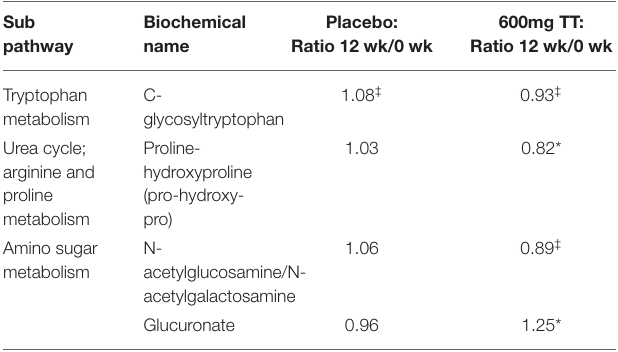
TABLE 2 | Changes in metabolites associated with redox environment in serum of the Placebo and the 600mg TT groups at 0 and 12 wk. Sub